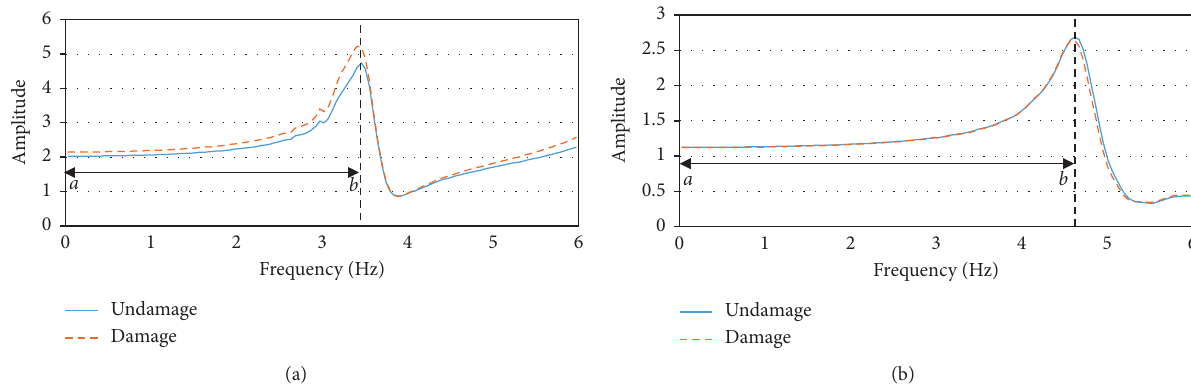
Figure 6: The substructure-based FRFs in the second substructure for case Dam_2F15%. (a) The substructure-based FRFs of the 2 nd DOF in ( ω ) . (b) The substructure-based FRFs of the 5 th DOF in the fifth substructure 􏽥 H ( 5 ) the second substructure 􏽥 H ( 2 ) 2